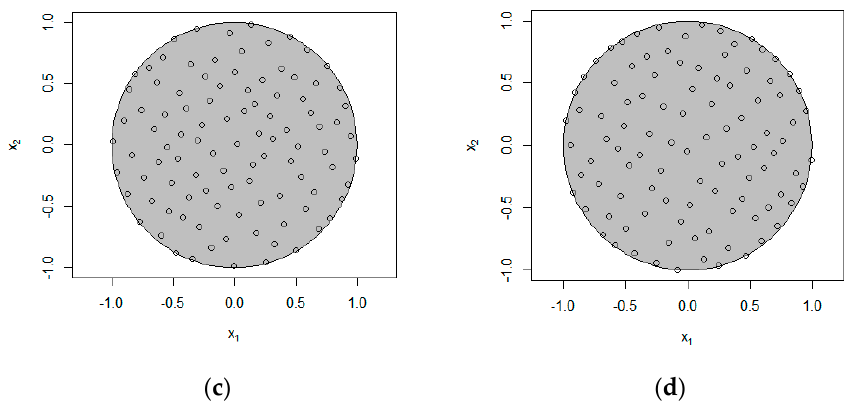
Figure 2. Design under constraints: ( a ) FFF, n = 10; ( b ) MP-CE, n = 10; ( c ) FFF, n = 100; ( d ) MP-CE, n = 100.